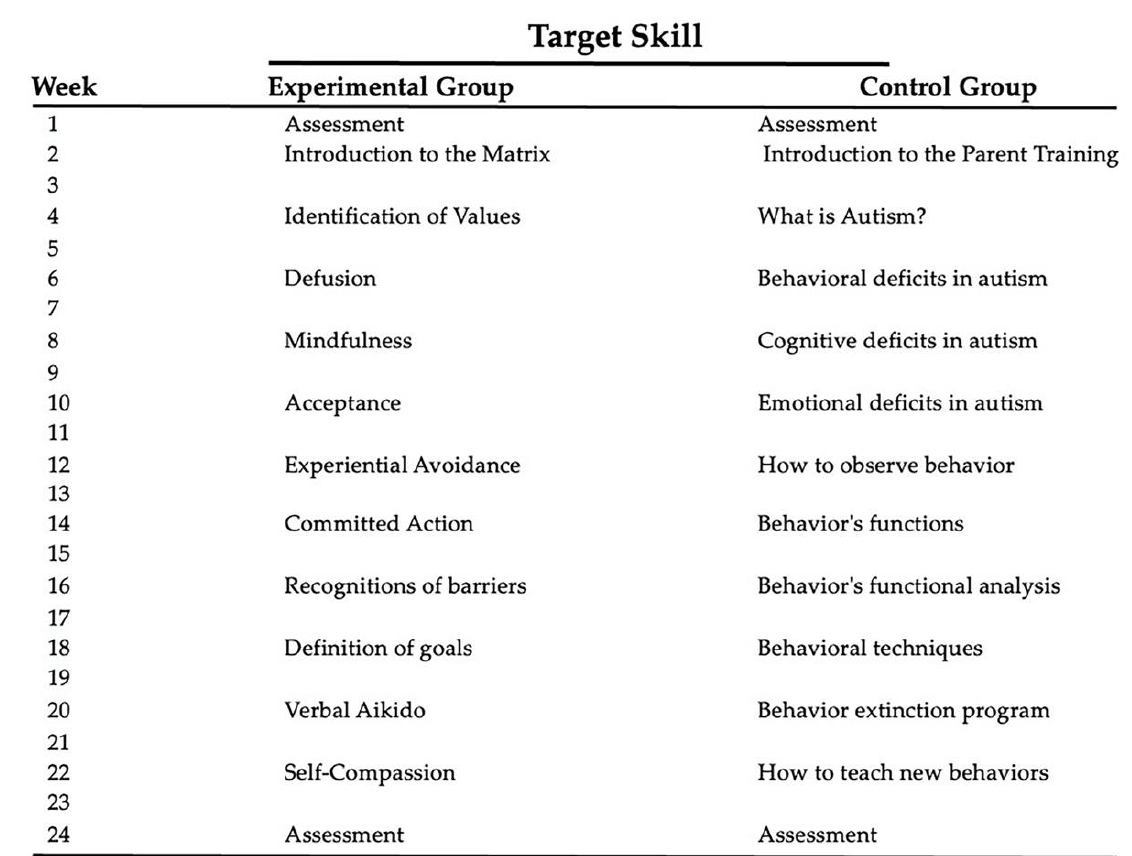
Figure 1. ACT matrix meetings and Parental Training meetings.